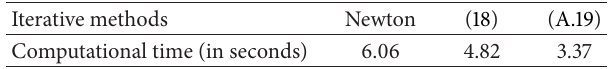
Table1:Comparisonofdifferentoptimalmethodsforfindingallthe zeros of f[x ] .